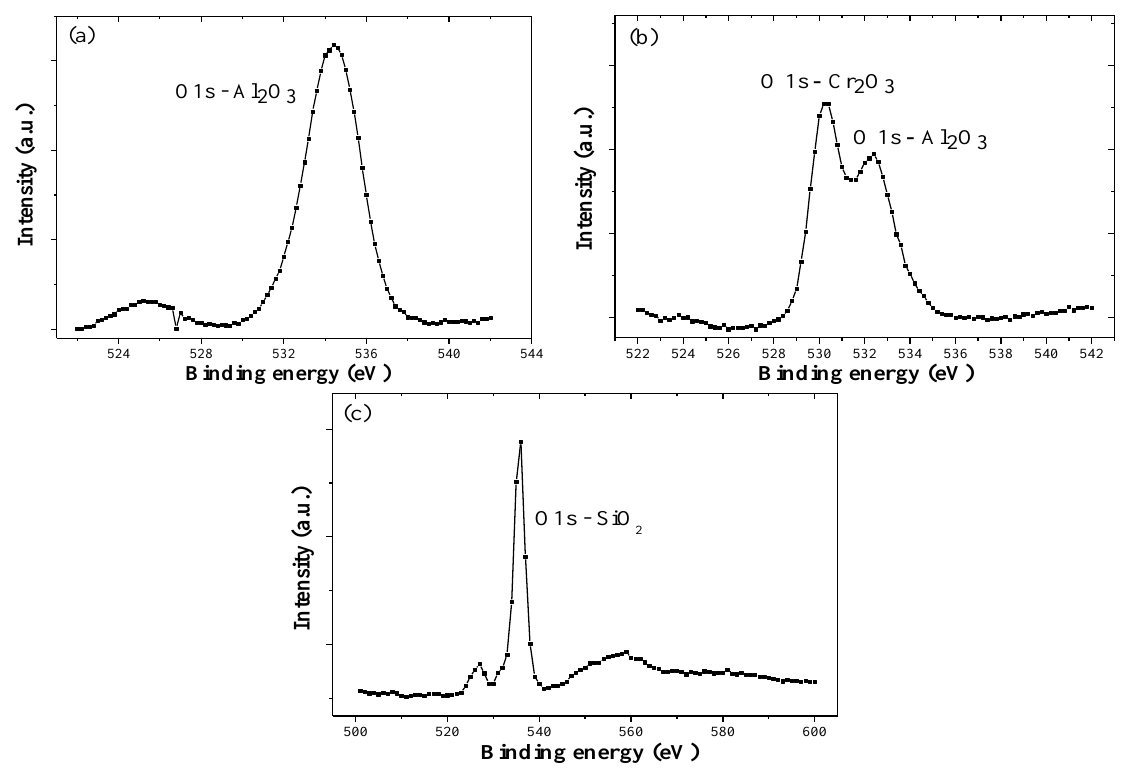
Figure 8. XPS spectrum of ( a ) hcp-AlN annealed at 300 °C; ( b ) 600 °C annealed (CrAl) and ( c ) 400 °C annealed